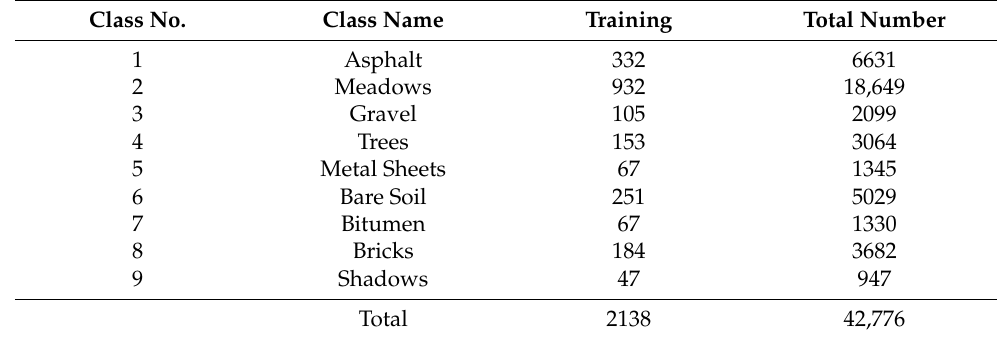
Table 1. Land-Cover Classes of The Pavia University Data Set. Class No.